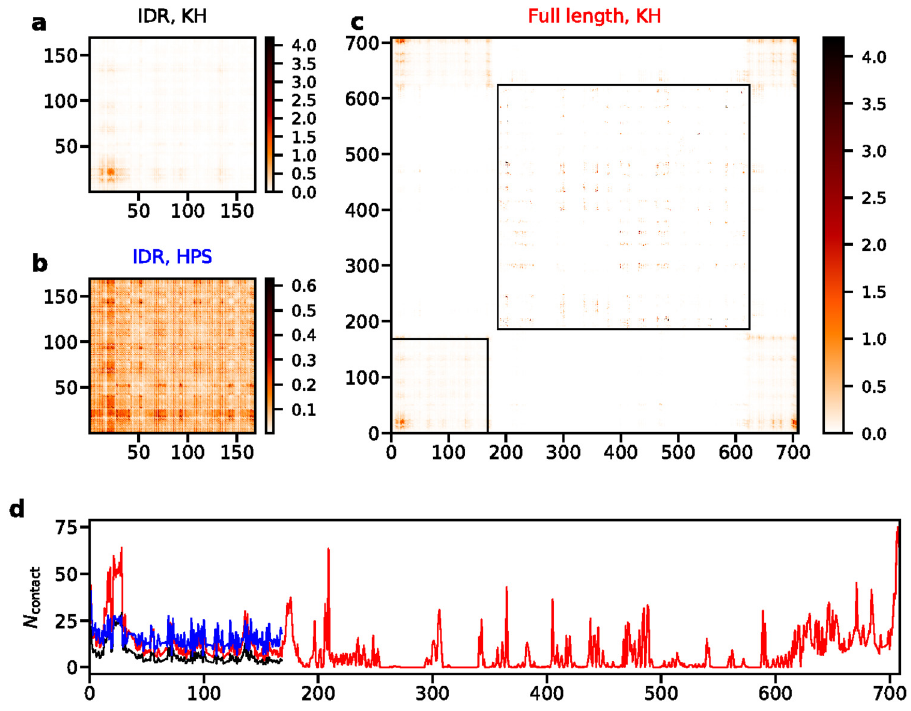
Fig 7. Number of intermolecular contacts per frame for LAF-1 with different models at 220K. a) Contact map of IDR LAF-1 with KH model. b) Contact map of IDR LAF-1 with HPS model. c) Contact map of full length LAF-1 with KH model. Black boxes illustrate the N-terminal IDR and the folded domain. d) Number of intermolecular contacts per residue per frame for IDR LAF-1 with KH model (black), IDR LAF-1 with HPS model (blue) and full length LAF-1 with KH model